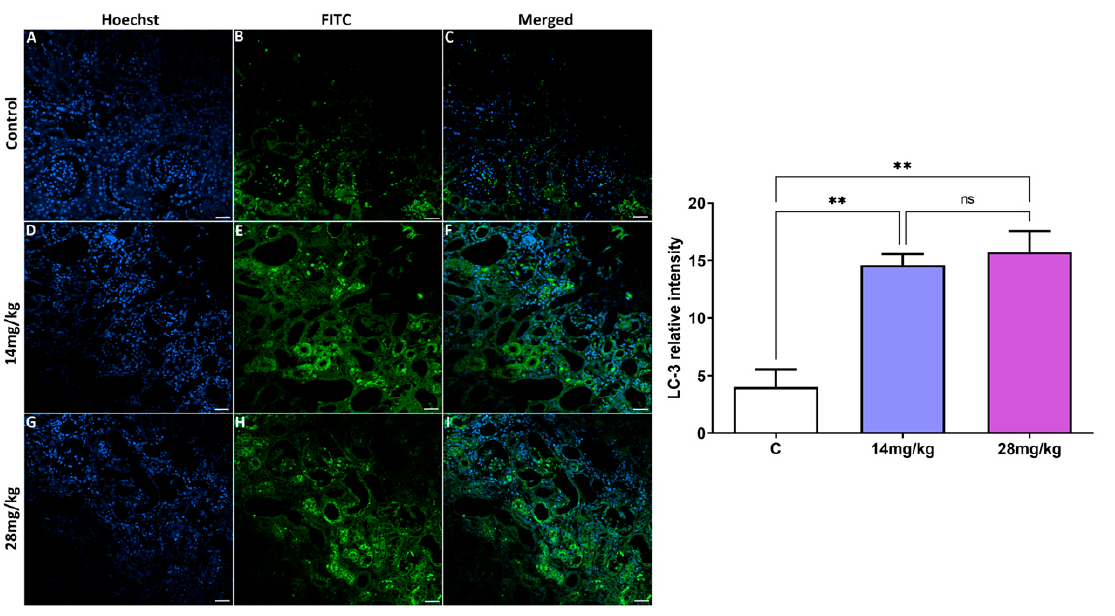
Figure 3. Effects of prenatal acephate exposure on the autophagic marker LC-3 in adult rat offspring. The autophagic marker LC-3 was evaluated via immunofluorescence staining and measurement of the relative fluorescence intensity ( A – I ), which was then quantified using Zen 3.1 service (ZEN lite) and the GraphPad Prism 9 program. An immunofluorescence analysis of LC-3 revealed the upregulation of this biomarker in both treatment groups (14 and 28 mg/kg) compared with the control group. All data are expressed as mean ± standard deviation (SD). Scale bar = 200 μ m. ** p < 0.01 ( n = 8), ns: nonsignificant.